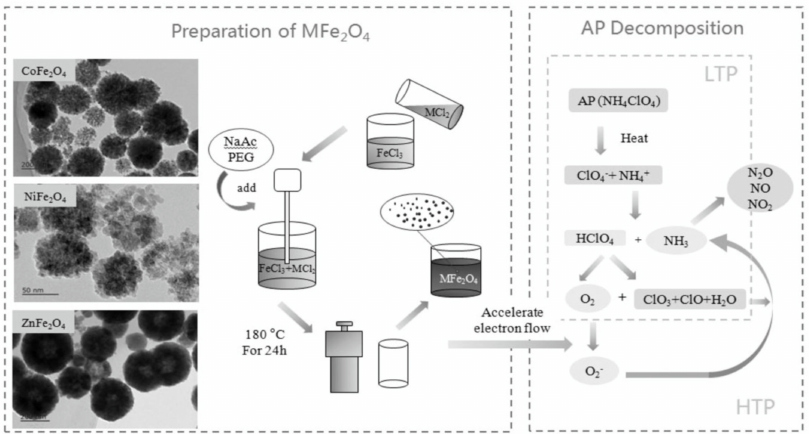
Figure 10. Illustration of ferrate fabrication and the catalytic mechanism for thermal decomposition of